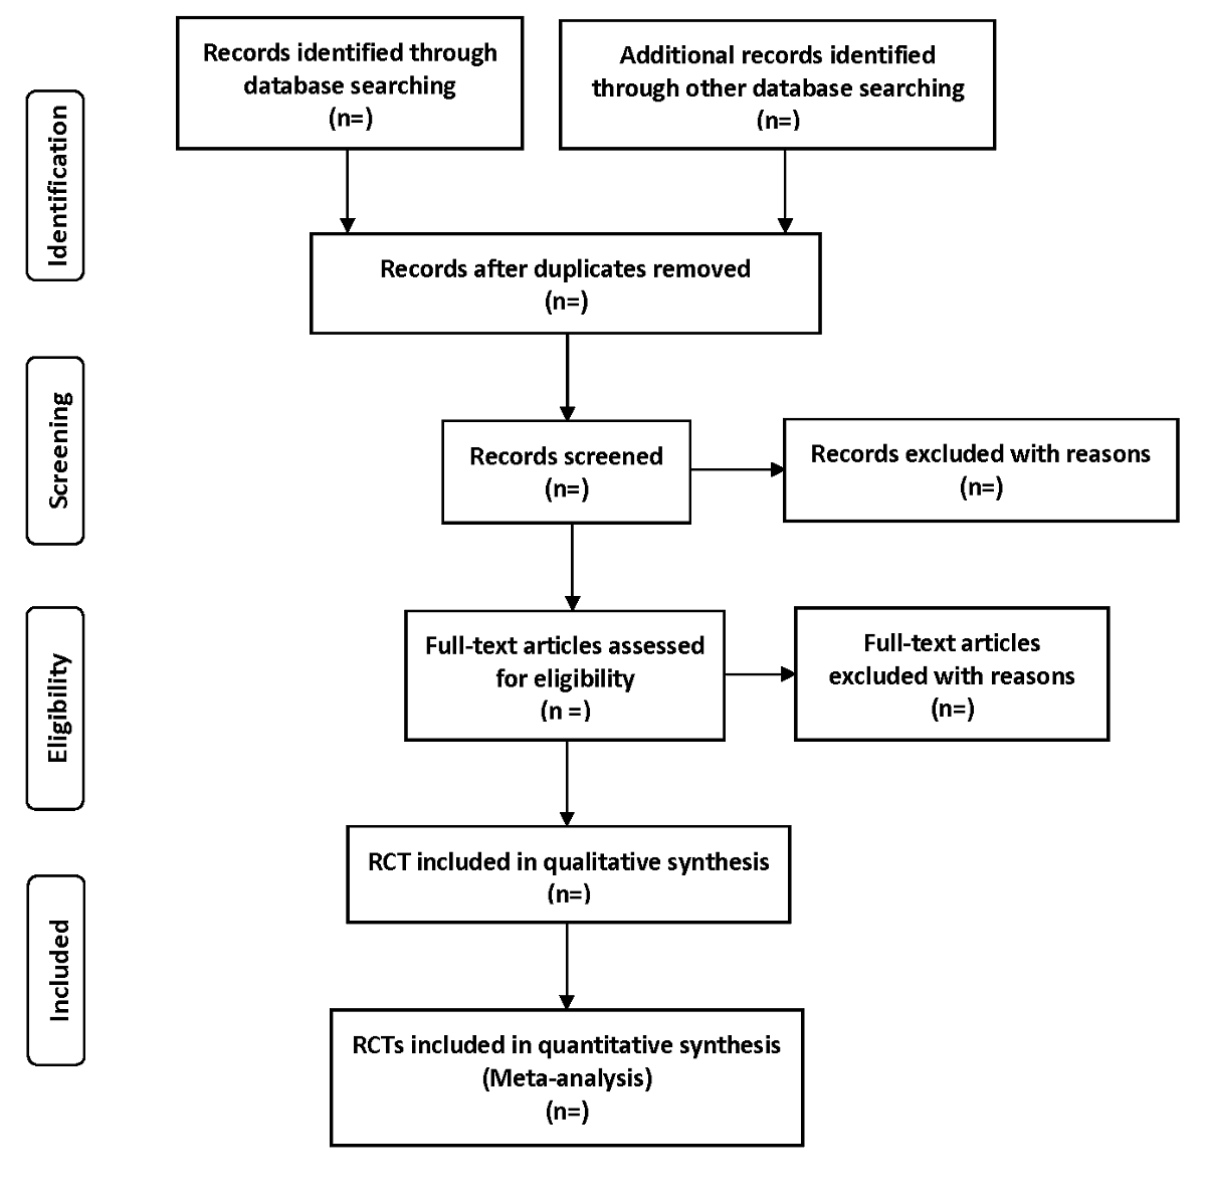
Figure 1. PRISMA diagram of identified